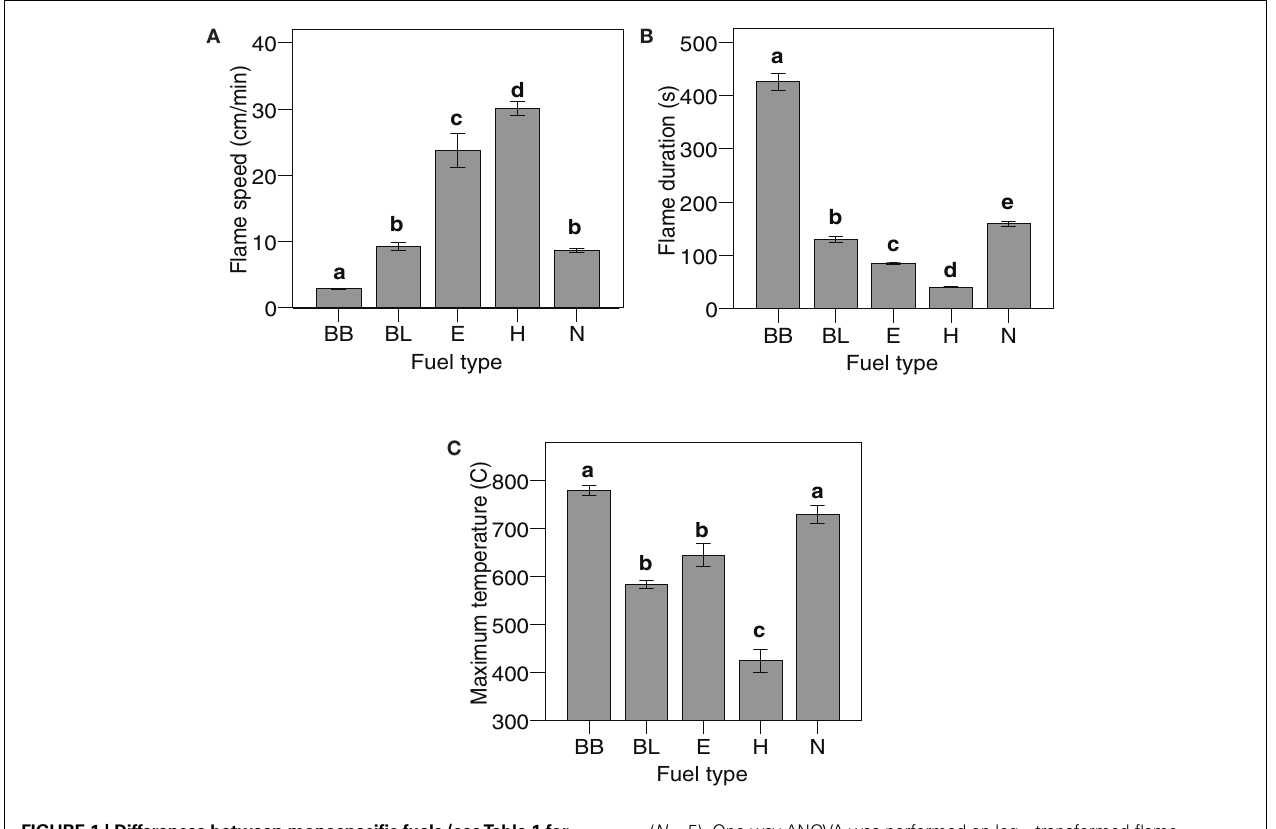
FIGURE 1 | Differences between monospecific fuels (seeTable 1 for codes) in (A) flame speed, (B) flame duration (time to extinction) and (C) maximum temperature. Means and SEs indicated, N = 6 for each material and flammability variable, except for Betula leaves for the variable flame extinction ( N = 5) and Nephroma for average maximum temperature